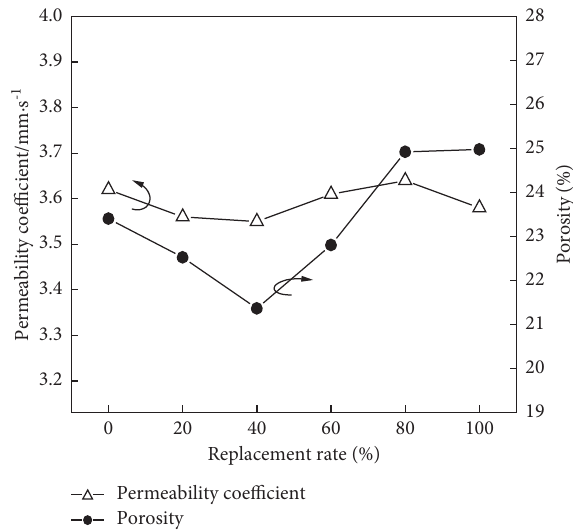
Figure 6: Relationships between porosity, permeability coefficient, and replacement rate of